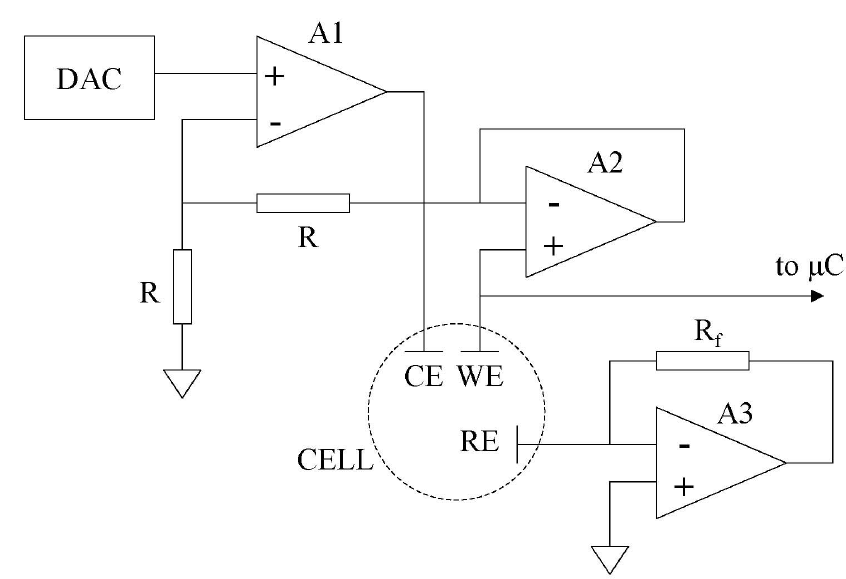
Figure 2. Potentiostat and drop monitoring